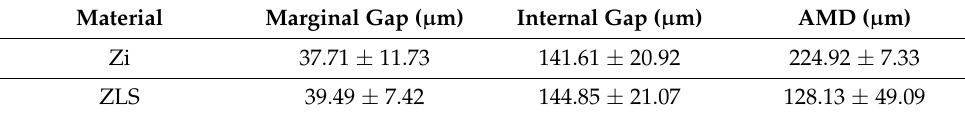
Table 2. Mean ± SD of marginal gap, internal gap and AMD of Zi and ZLS crowns (n = 16).